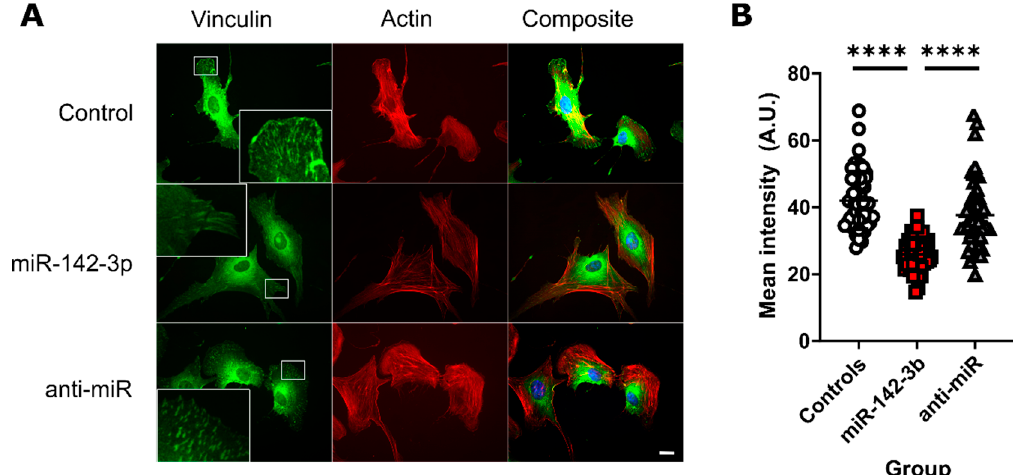
Figure 3. Vinculin plaques are less prominent in miR-142-3p-transfected cells. Green fluorescent staining represents vinculin, whereas red fluorescent staining shows fluorescently labelled phalloidin binding to actin filaments. ( A ) There are fewer vinculin plaques and the plaques have lower green fluorescence intensity compared with the controls and anti-miR transfected St-T1b cells. Vinculin also localized to the endoplasmic reticulum and the Golgi apparatus. Scale bar, 10 µm. ( B ) Quantification shows that the intensity of vinculin in focal adhesions is reduced after transfection with miR-142-3p ( n = 43–54, Kruskal-Wallis test). Data in the whole figure panel represent mean ± s.d. For all figures in this panel **** p < 0.0001 and n.s. p > 0.05.